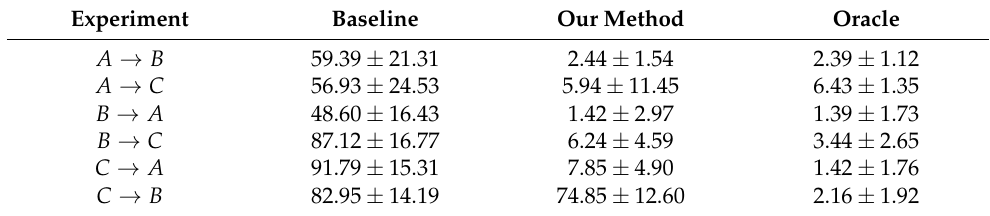
Table 3. Results of our unsupervised domain adaptation approach in rMAE (%). Each row shows the results of the models trained with one source dataset and tested on another one. The final column represents the performance of a fully supervised model with access to both source and target domain labels.